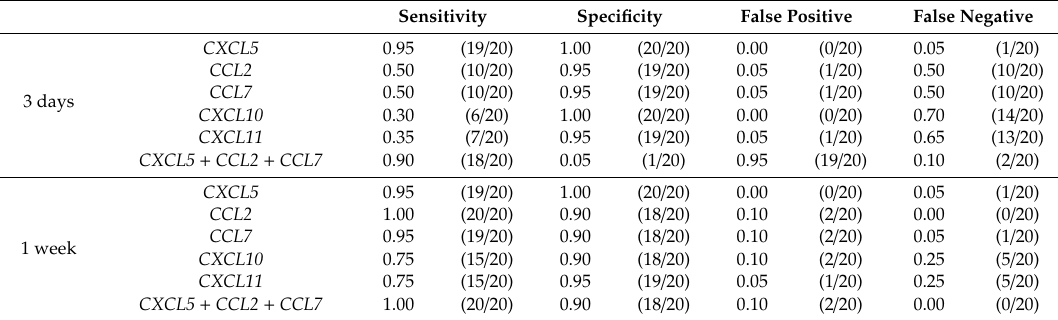
Table 4. Sensitivity and specificity of gene expression of five chemokines in the pulmonary toxicity of